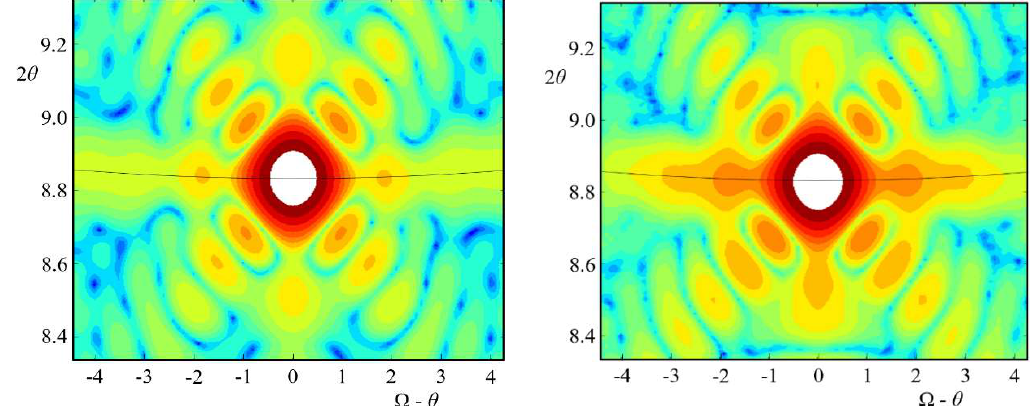
Figure 6. ( a ) The calculated diffraction pattern from an octahedron-shaped crystal (with its facets out of the plane of diffraction). This is the pattern for a perfect array of stationary point scatterers, with the dimensions on each row of atoms randomly varied by 5% to reduce the dominance of the shape effects. ( b ) The calculated diffraction pattern from a single photon interacting with the same crystal as in ( a ), but with each point scatterer having a positional uncertainty randomly sampled from a Gaussian distribution, with σ = 0.005 nm to represent thermal vibrations and what a photon samples. The line of intensity enhancement close to the Bragg angle of 8.82 0 is clear to see in ( b ) compared with ( a ).